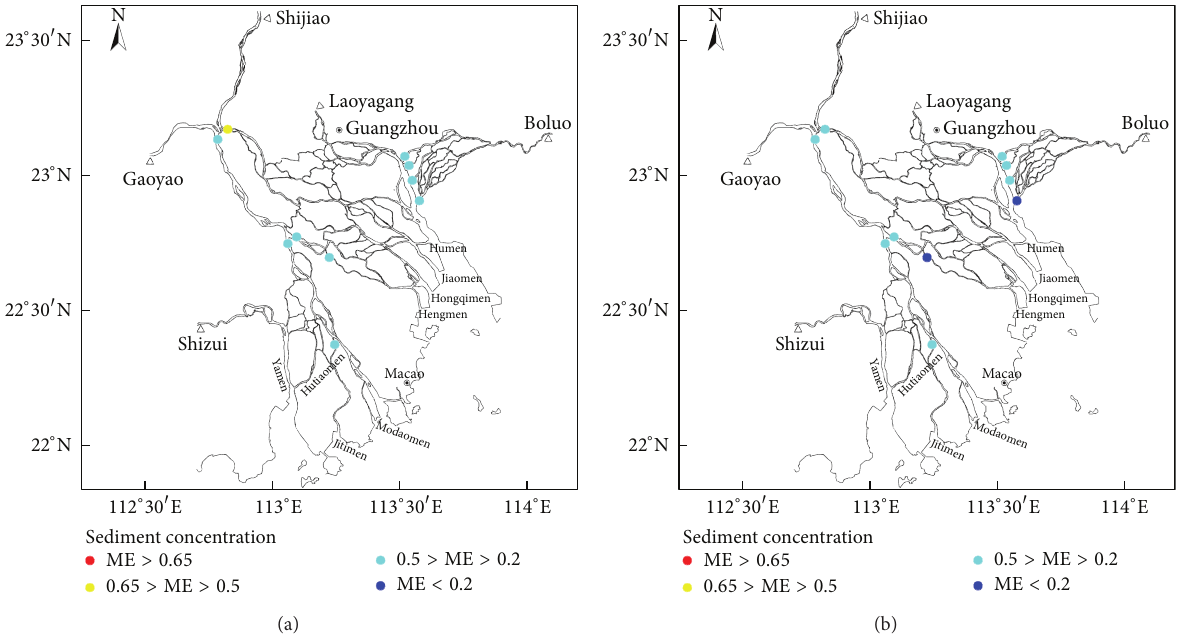
Figure 7: (a) The calibration of suspended sediment concentration from July 18 to July 19, 1998. (b) The validation of suspended sediment concentration from February 7 to 16,